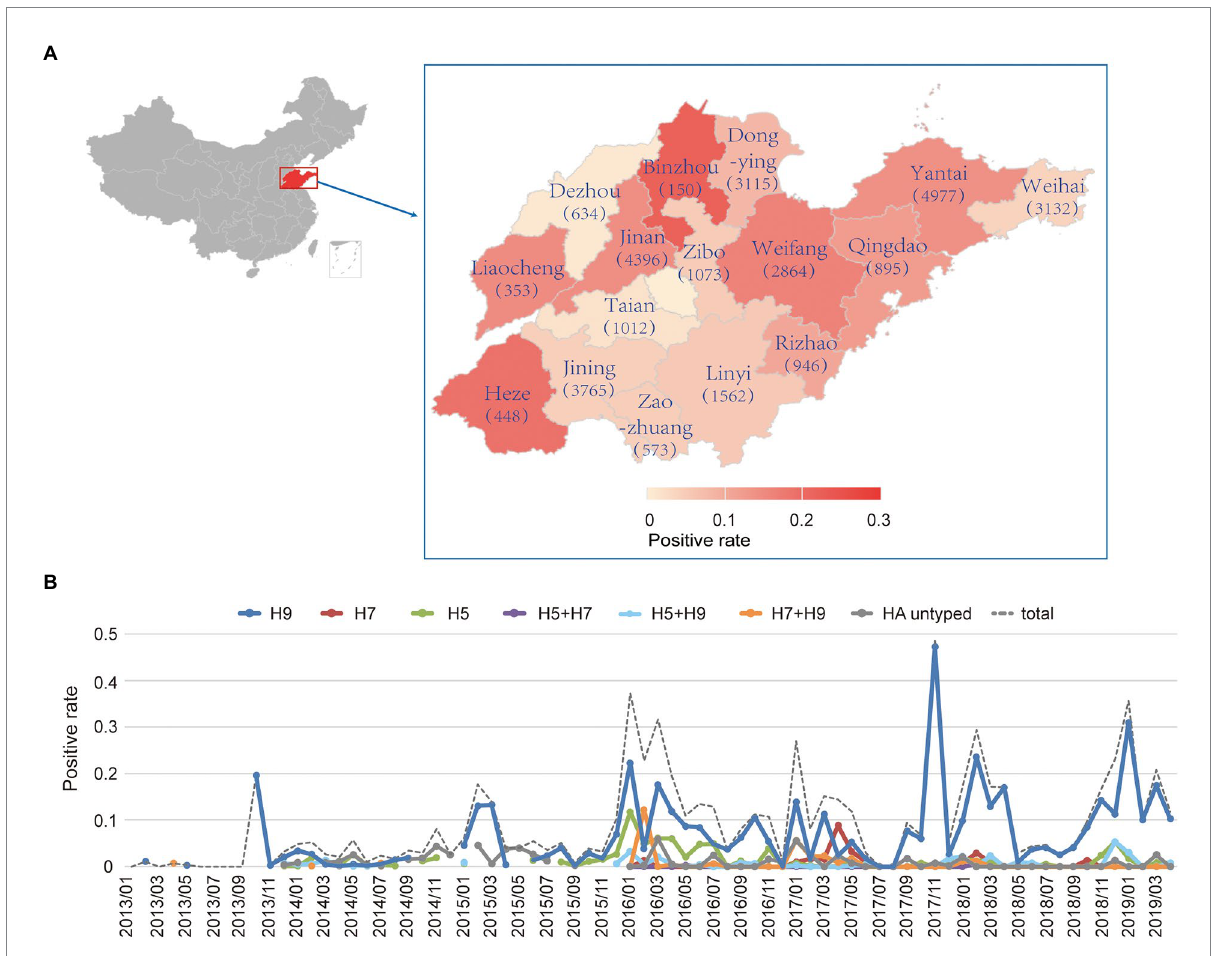
FIGURE 1 Surveillance of AIVs in LBMs of Shandong province from 2013 to 2019. (A) The number of samples and positive rates of AIVs by city in Shandong province. The cities were colored by the positive rate. The numbers in parentheses referred to the number of samples surveyed in the city. (B) The monthly positive rate of different HA subtypes or subtype combinations of influenza A viruses.